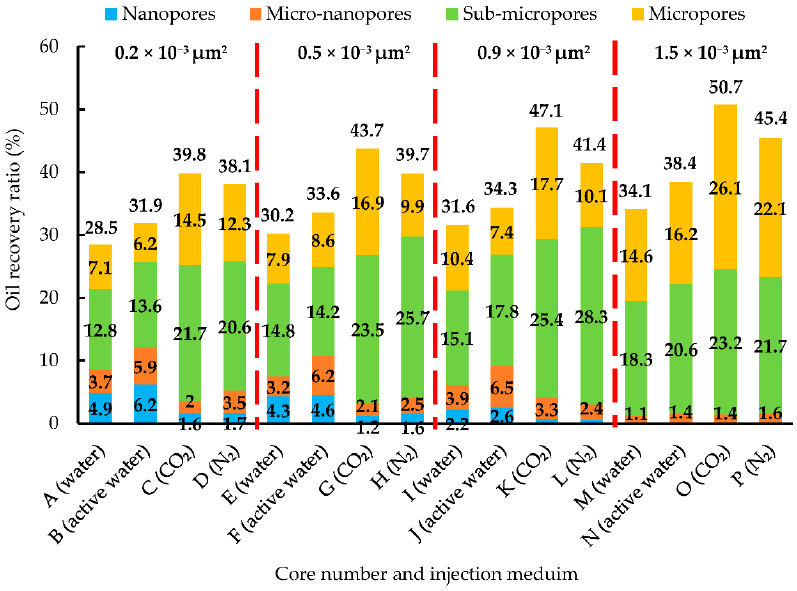
Figure 7. Oil recovery ratio of tight cores under different injection media.